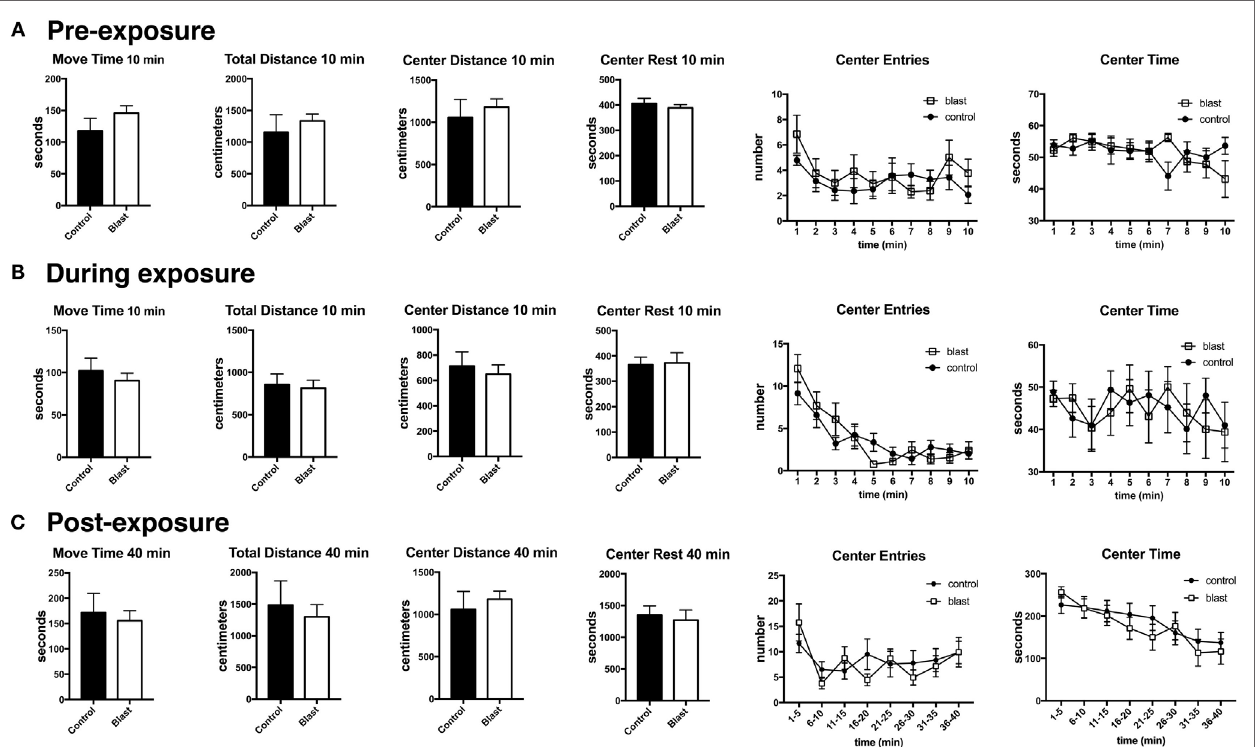
FigUre 2 | no acute changes in open field activity of blast-exposed rats during or immediately following a predator scent exposure . Open field activity (move time, total distance, center distance, center rest time, center entries, and center time) was measured before (a) , during (B) , and immediately after (c) exposure to a predator scent. Error bars indicate ± SEM. There were no statistically significant differences between blast-exposed and controls in any of the measures (unpaired t -tests). See text for discussion of additional statistical